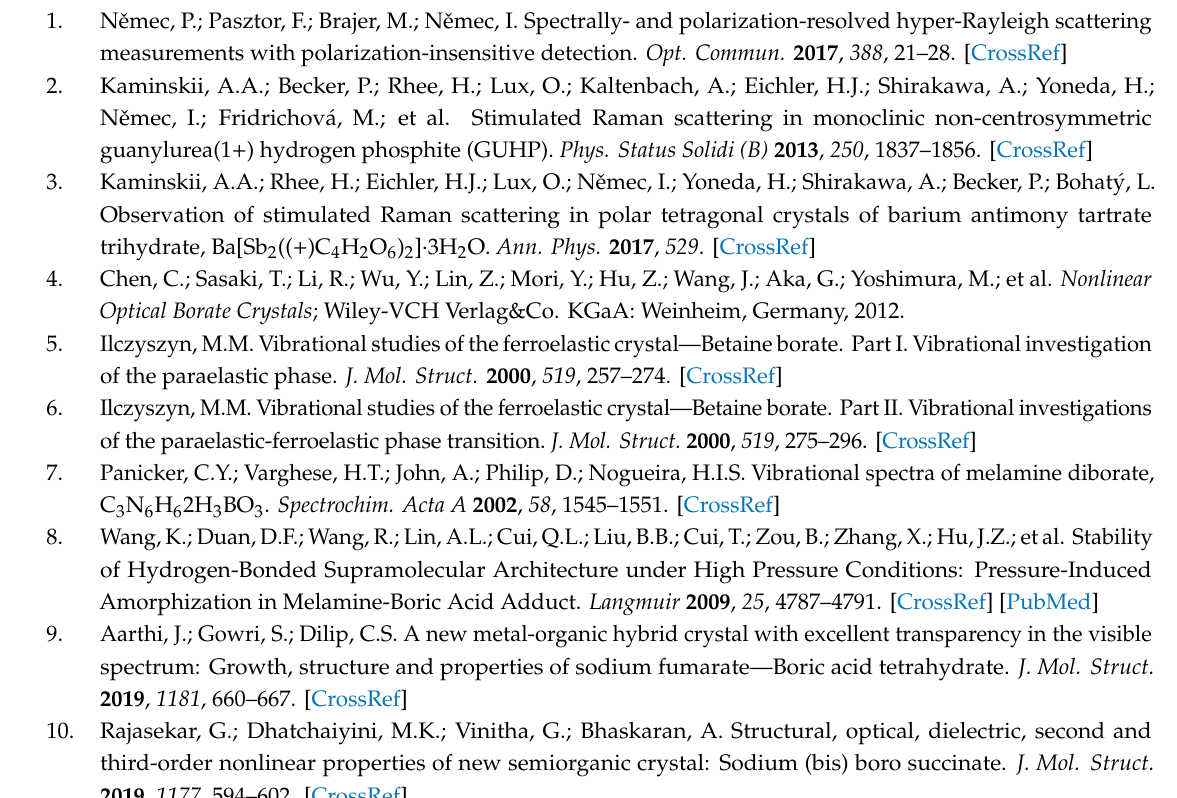
Figure S6. The UV-Vis spectrum of polycrystalline (2-AMP) 3 (H 3 BO 3 ) 2